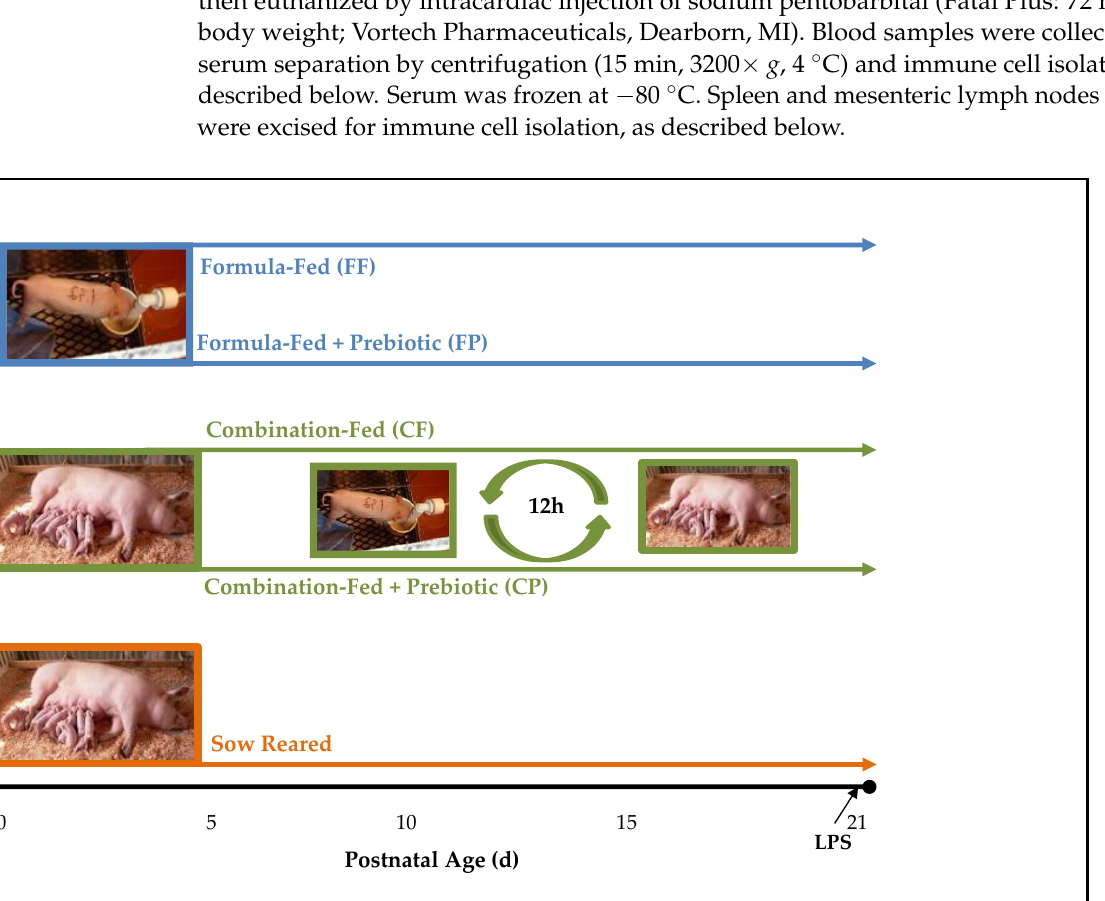
Figure 1. Study design. All piglets in all groups were vaginally delivered and remained with the sow for ~4 hours. Piglets were then randomized into five experimental groups: sow-reared (SR, n = 9), formula-fed (FF, n = 12), formula-fed with prebiotics (FP, n = 10), combination-fed (CF, n = 8), or combination-fed with prebiotics (CP, n = 8). SR piglets remained with sows during the entire study. FF and FP piglets were removed from the sow after 4 hours. CF and CP piglets remained with two sows (4 – 5 piglets per diet for each sow) for the first 5 day postpartum, then were rotated between nursing sows and formula feeding every 12 hours. The formula was a non-medicated, commercial sow-milk replacer. Galactooligosaccharides (GOS, PURIMUNE TM ) and agave inulin (BIOAGAVE TM ) were added to the formula at a total concentration of 4 g/L in a 4:1 ratio. An i.p. LPS dose (10 µg/kg BW) was given 2 hours before euthanasia on day 21.